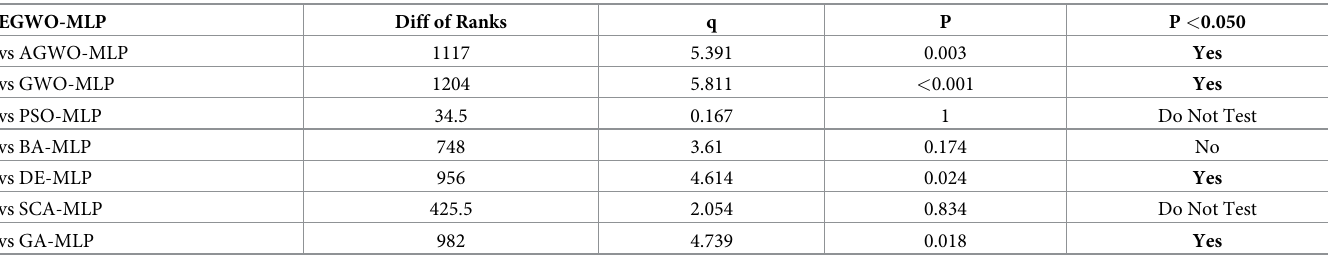
Table 8. Results for RM ANOVA on RANKS of the Portuguese (Por.) subject achievement prediction. EGWO-MLP Diff of Ranks q